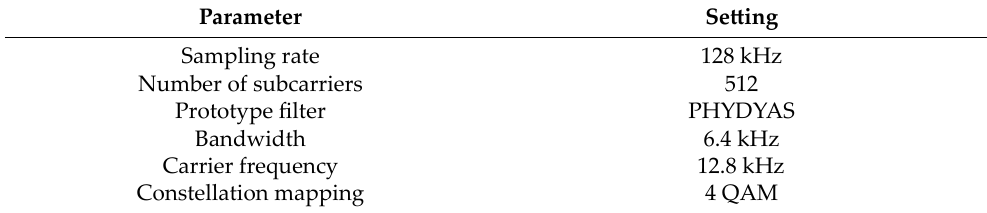
Table 2. FBMC parameter settings.